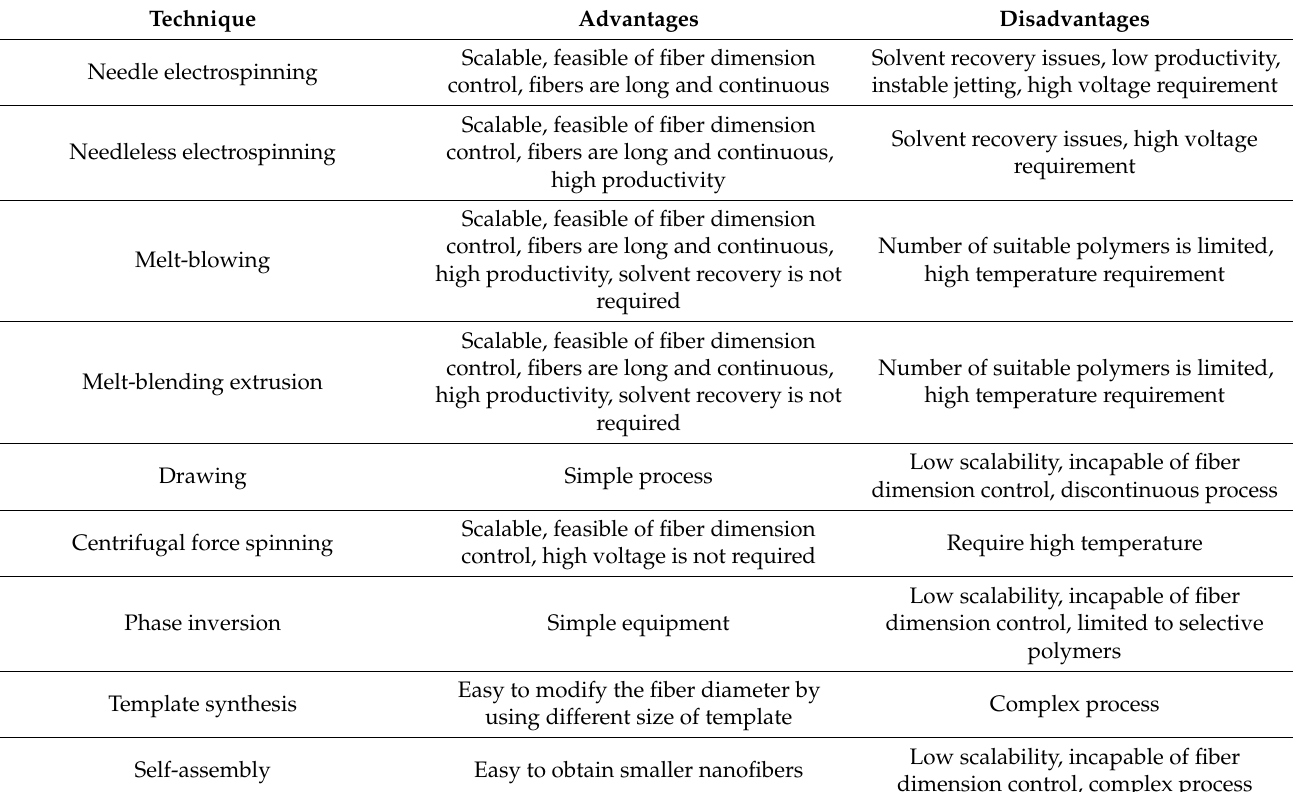
Table 2. Comparison of different nanofiber production